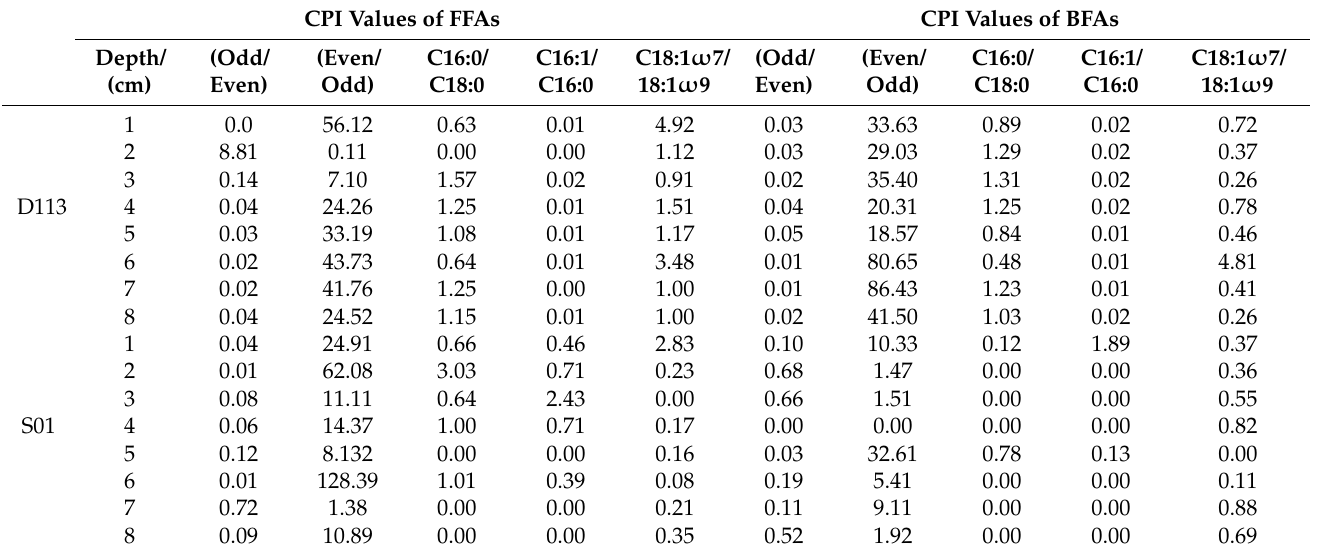
Table 2. CPI values of fatty acids from the sediments of the Yap Trench.